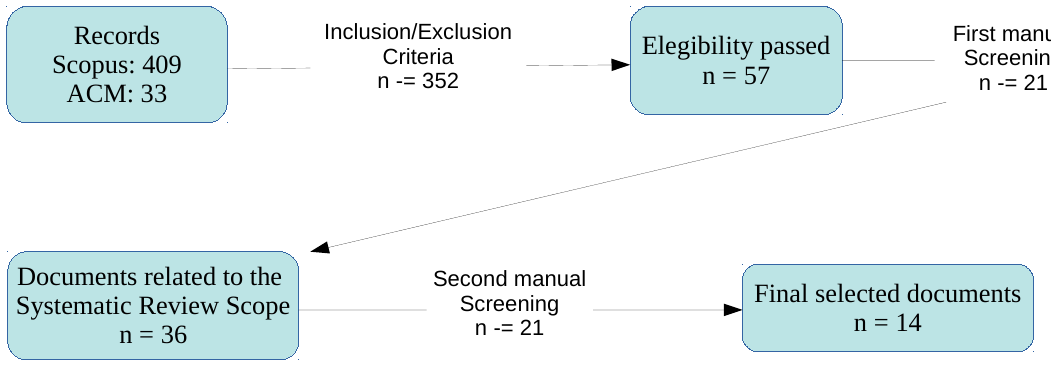
Figure 1. Flow diagram of the systematic review process.